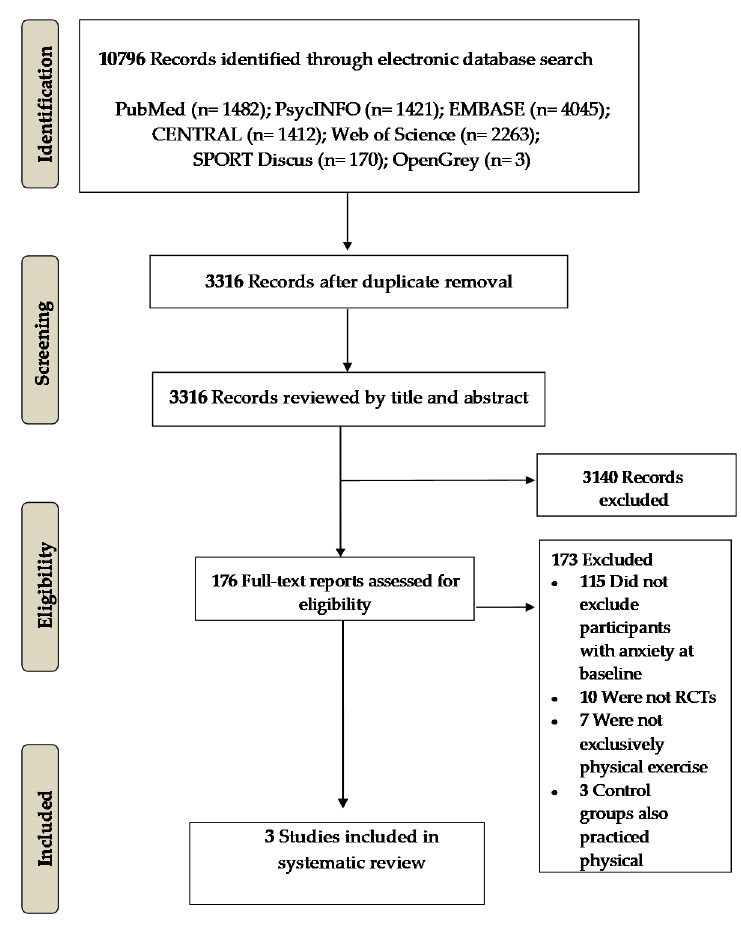
Figure 1. PRISMA flowchart of the randomized controlled trials included.